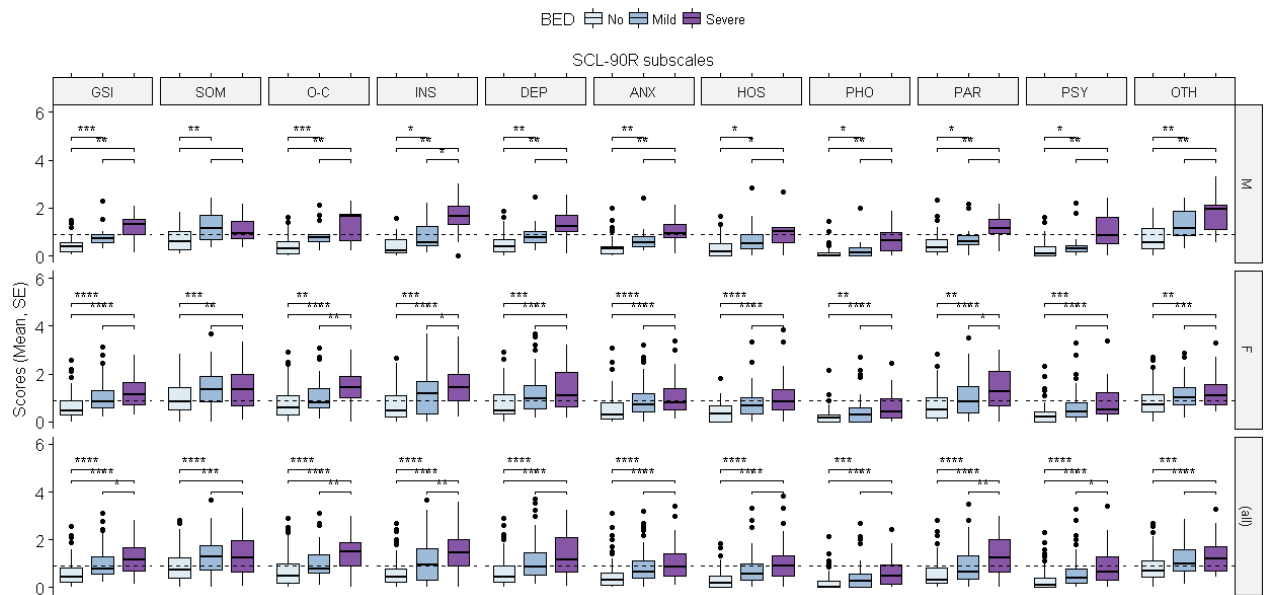
Figure 4. The effects of binge eating disorder severity and gender on SCL-90-R scores. The differences between the groups were evaluated using the Wilcoxon test: dashed lines, general population cut-offs (0.9); GSI, Global Severity Index; SOM, somatization (severe: ß = 0.45, p = 0.013; mild to moderate: ß = 0.530, p = 0.0076); O ‐ C, obsessive–compulsive (severe: ß = 0.859, p = 0.0003; mild to